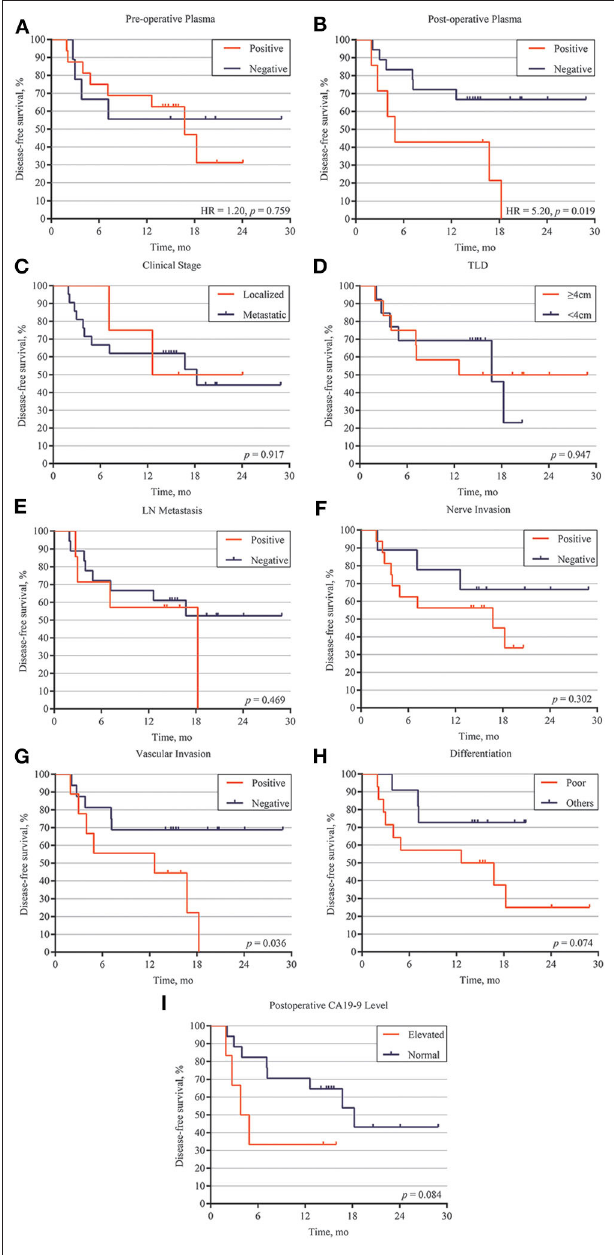
FIGURE 3 | Correlation between ctDNA, clinical high-risk factors and disease relapse. (A) Disease-free survival analysis of preoperative ctDNA detection patients with PDAC. (B) Disease-free survival analysis of postoperative ctDNA detection patients with PDAC. Disease-free survival analysis of 27 patients with different clinical features, including localized /metastatic clinical stage (C) , tumor largest size (D) , lymph node (LM) metastasis (E) , nerve invasion (F) , vascular invasion (G) , differentiation (H) , and postoperative CA19-9 level (I)